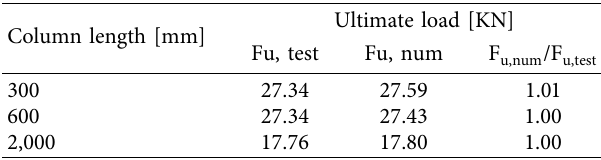
Figure 6: Lowest buckling mode of the 600mm column (a) and global buckling mode of the 2,000mm column (b). Table 3: Comparison of test and FEA ultimate loads of unbraced specimens of first test series